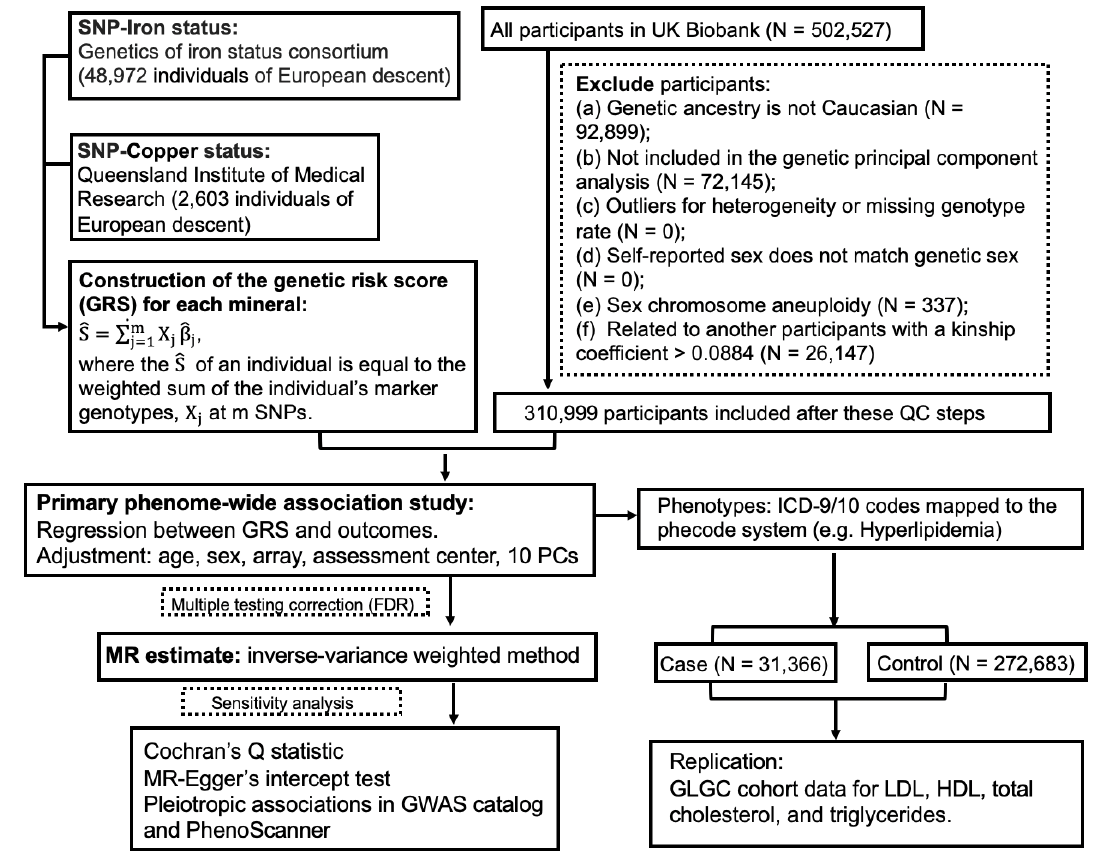
Figure 1. A flow chart of the study design.